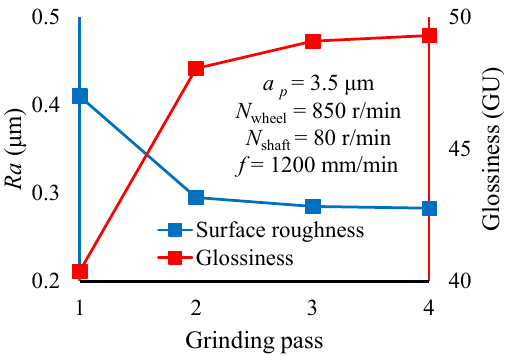
Figure 6. The surface roughness and glossiness of four consecutive passes.